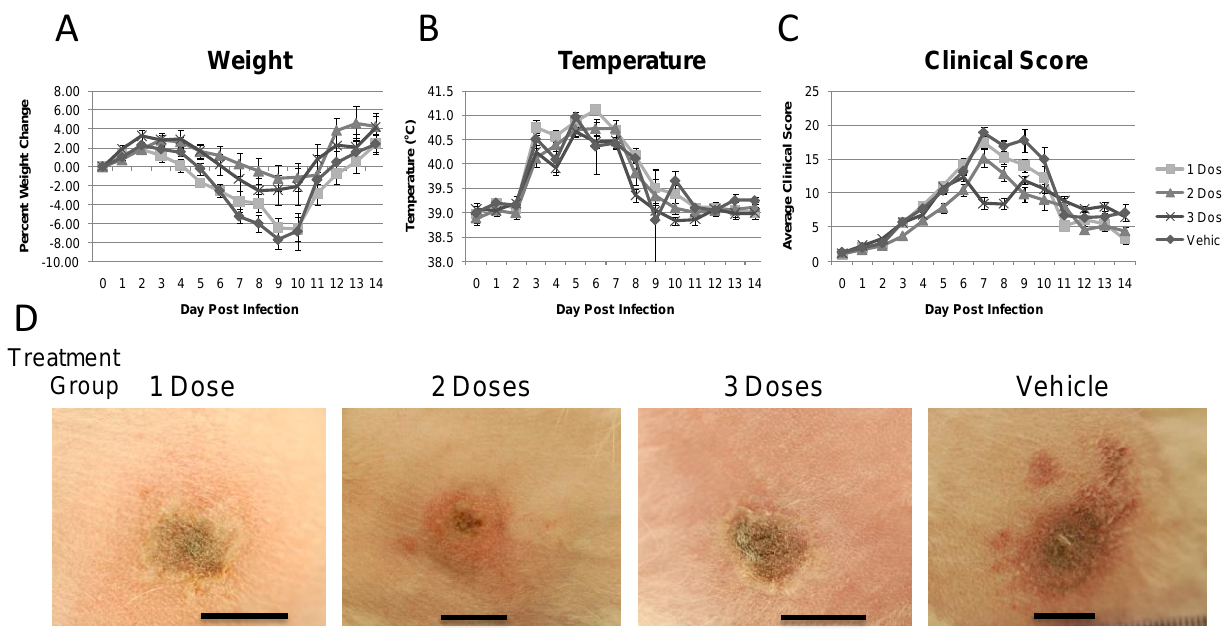
Figure 3. Animals treated beginning at the appearance of secondary lesions. Groups of 12 animals were treated with CMX001 1, 2 or 3 times every other day beginning at the appearance of secondary lesions in the ears. Animals were dosed at concentrations and schedules as outlined in Table 2. (A) Average weight change over time for each group. Negative values represent weight loss. (B) Average body temperatures over time. Temperatures over 39.5 °C are considered a fever. (C) Average clinical score over time. Error bars represent SEM. (D) Photographs of primary lesions from each treatment group at 8 dpi. Bar represents